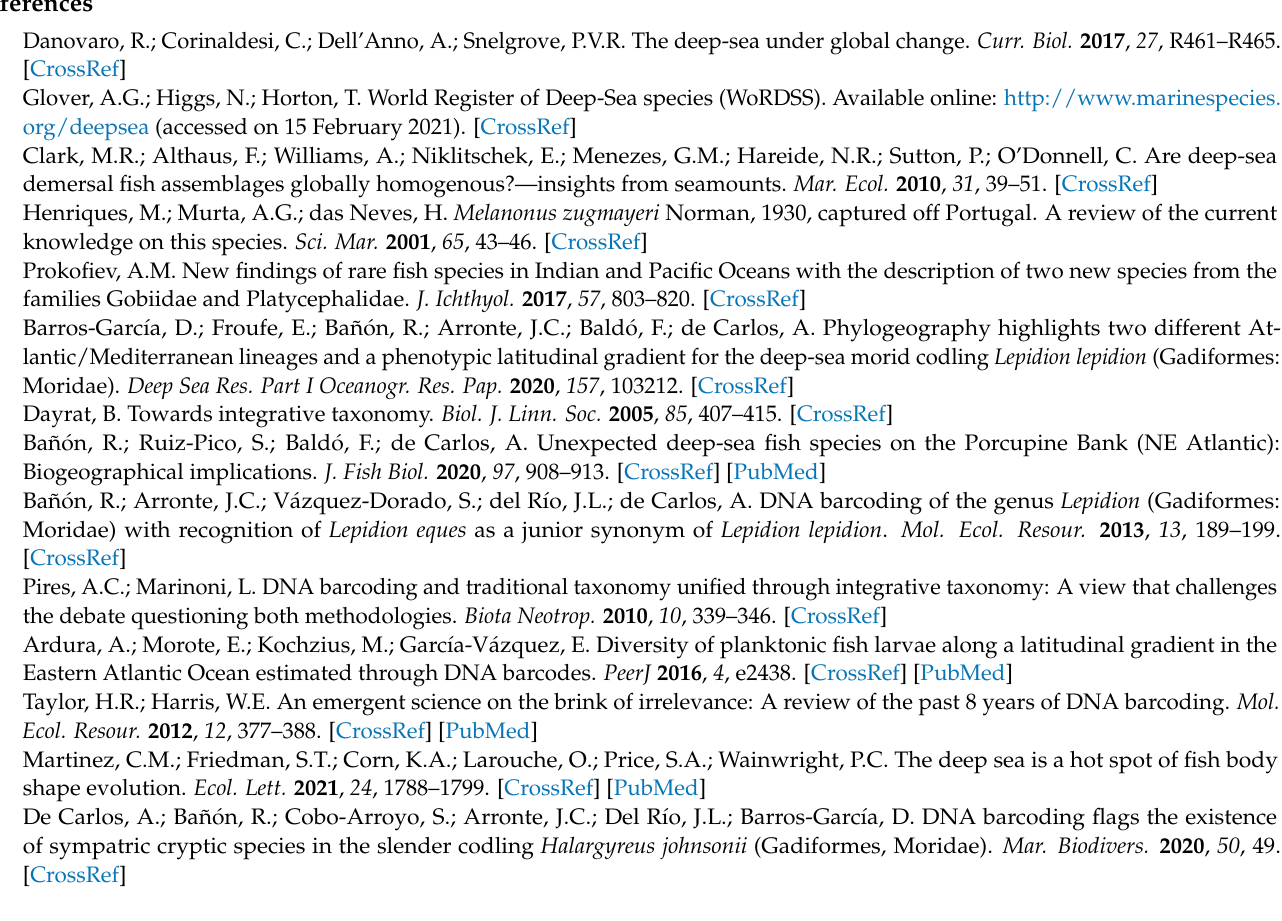
terraenovae . Figure S2: Neighbor-Joining trees of Lycodes terraenovae mitochondrial Cyt b (A) and 12S rDNA (B) nucleotide sequences based on p-distances. The percentage of replica trees in which the associated taxa clustered together in the bootstrap test (2000 replicates) are shown next to the branches when values are higher than 70%. The trees are drawn to scale, with branch lengths in the same units as those of the genetic distances used to infer the cladograms. Differences among sequences were computed as p-distances and are in the units of the number of base differences per site. All ambiguous positions were removed for each sequence pair (pairwise deletion option). The analyses were conducted in MEGA